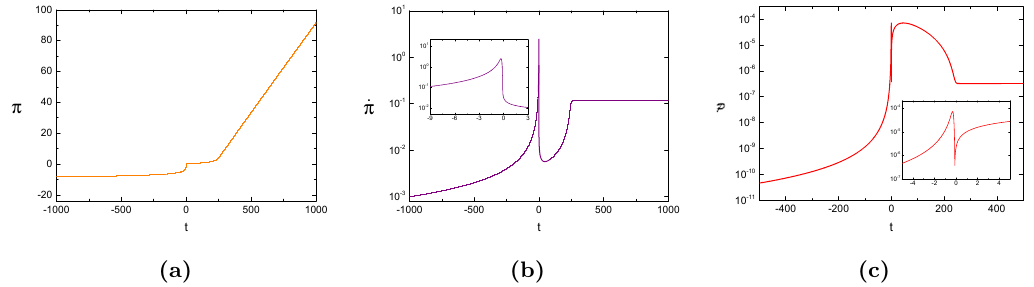
Figure 3. Evolution of the DHOST field π (represented by the solid orange curve), and its time derivative ˙ π (represented by the solid purple curve), as a function of cosmic time t . We also plot out the function P , whose positive behavior is required to stabilize the dynamics of the DHOST field π , as discussed in the last paragraph of subsection